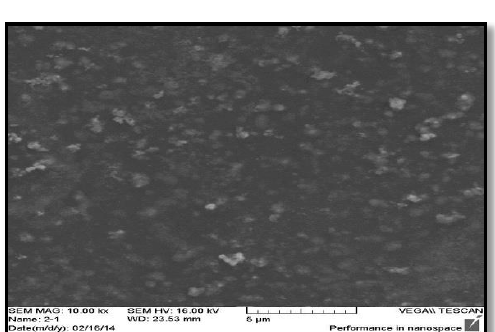
Fig.10: (SEM) micrograph images forZ :S . 0.25 0.75